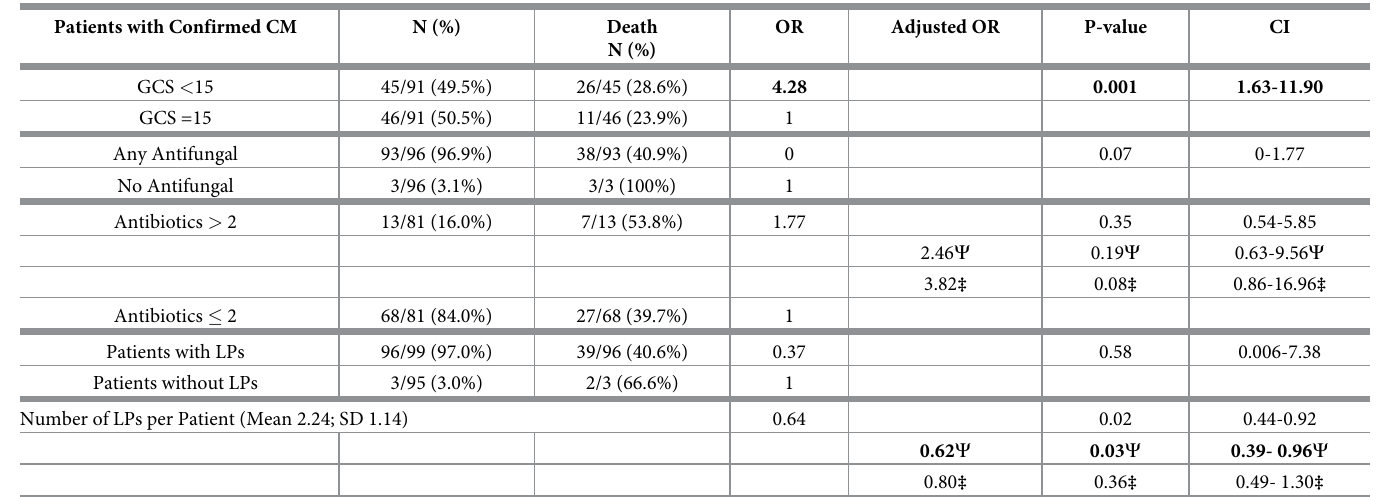
Table 7. Factors associated with mortality among patients with confirmed CM in group